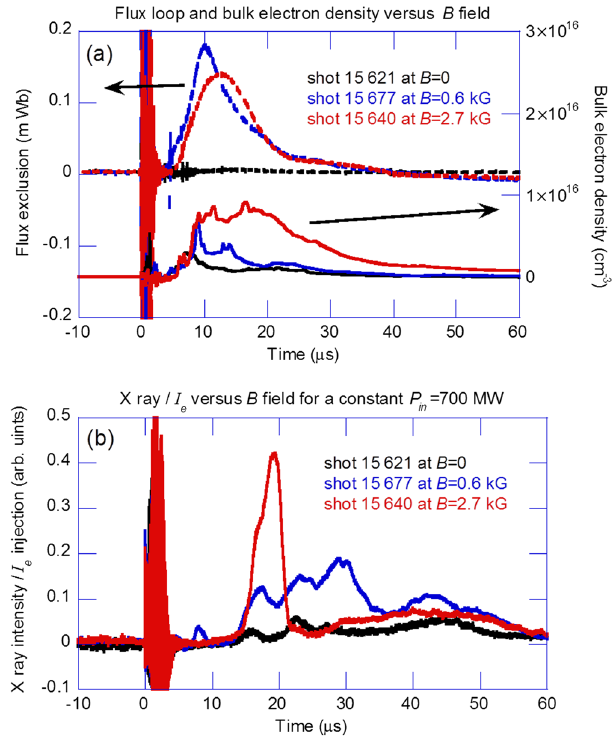
FIG. 5. Plasma parameters as a function of plasma injection power at B field of 2.7 kG: (a) flux exclusion and bulk electron density, (b) normalized x-ray emission intensity.